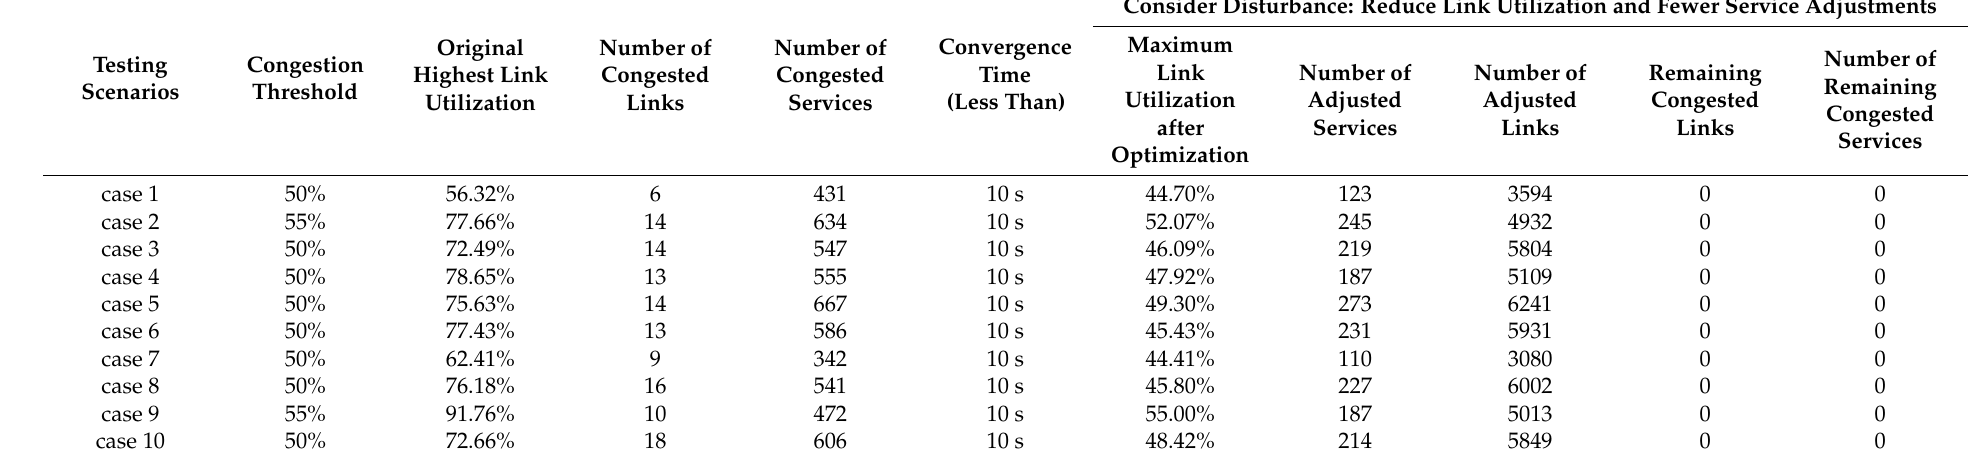
Table 8. Verification of traffic optimization based on load balancing and disturbance control